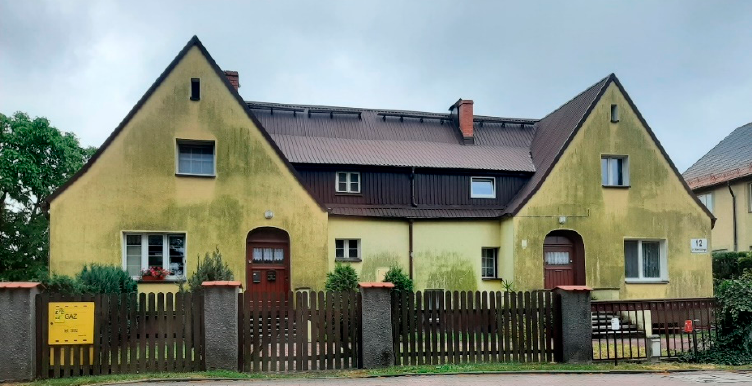
Figure 1. Changes in the exterior wall’s finished surface (author’s archives).